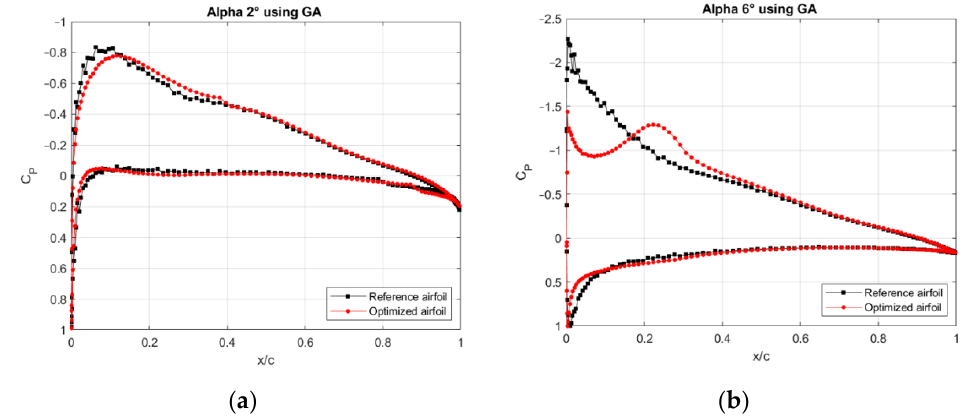
Figure 6. Cp distribution versus chord length using the GA algorithm for the ( a ) angle of attack of 2° and ( b ) of 6°, compared to the reference airfoil.